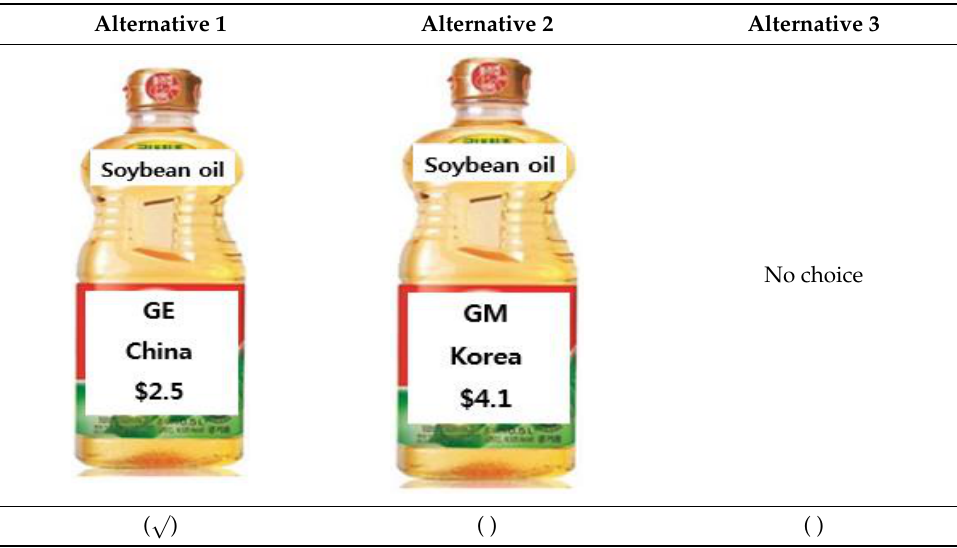
Table 4. The example of the presentation format of a choice set.